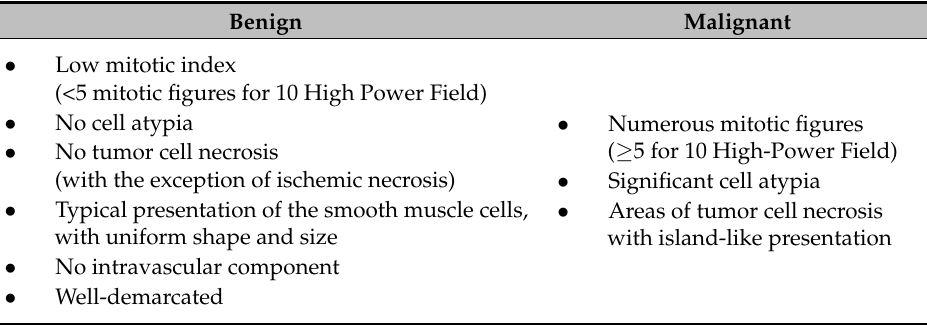
Table 2. Differentiation criteria for uterine smooth muscle tumors [53,54].